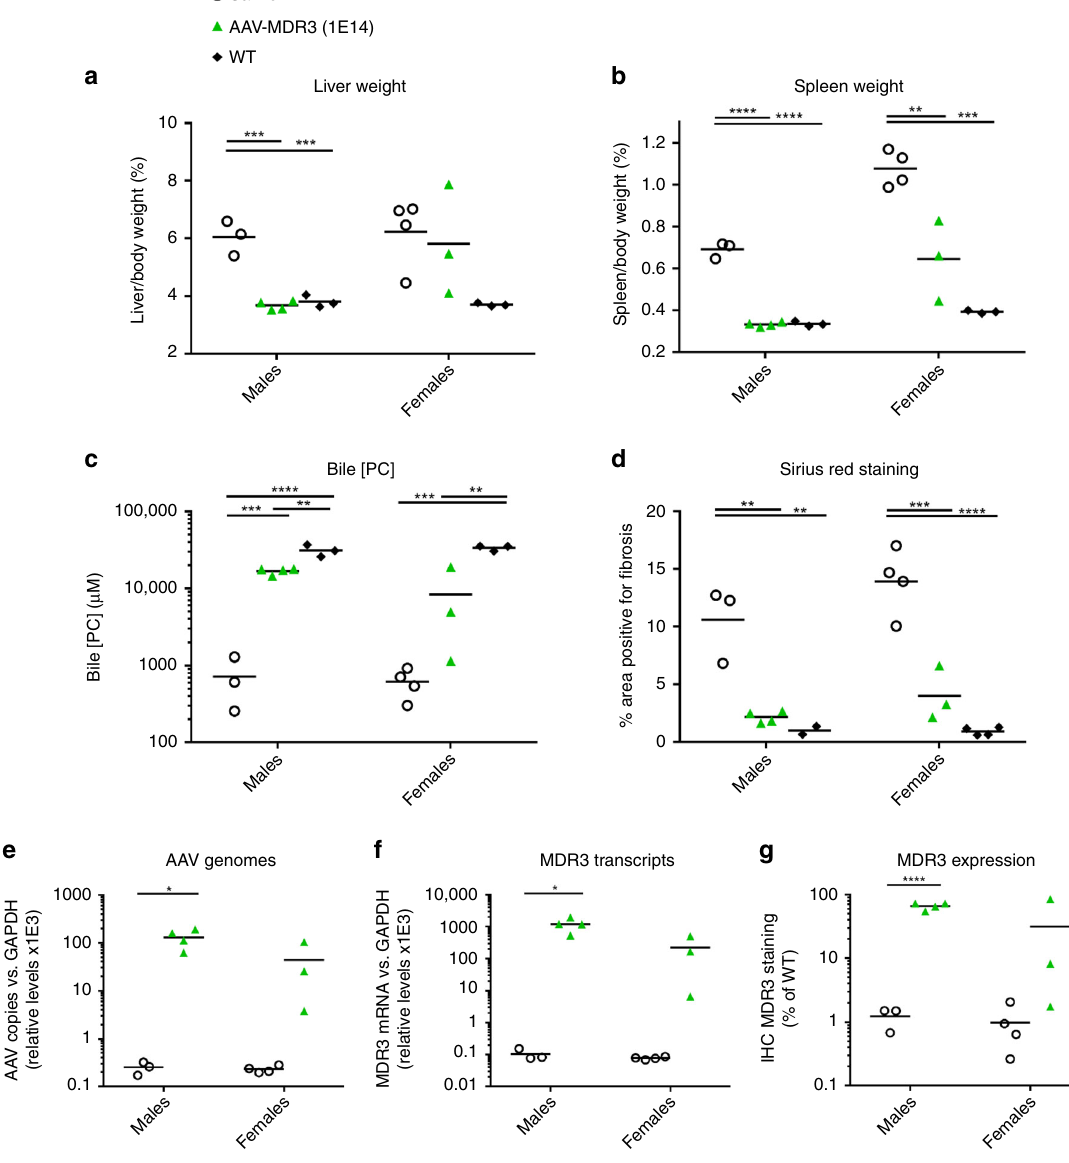
Fig. 7 PFIC3 disease parameters in Abcb4 − / − mice treated at 5 weeks of age with AAV-MDR3-Aco. At the time of sacri fi ce, liver ( a ) and spleen ( b ) weight as a percent of body weight, PC concentration in bile ( c ), liver fi brosis ( d ), AAV genomes ( e ), MDR3 transcripts ( f ), and MDR3 protein expression ( g ) were measured for Abcb4 − / − mice treated with AAV-MDR3-Aco at 1 × 10 14 VG/kg 1× (green triangles; n = 4 M/3 F), and saline-treated controls (open circles; n = 3 M/4 F) and untreated WT mice (black diamonds; n = 3 M/3 F). Animals were sacri fi ced 12 weeks after treatment. Statistics (one-way ANOVA/Tukey ’ s multiple comparisons test): *, p < 0.05; **, p < 0.01; ***, p < 0.001, ****, p < 0.0001. a – d F values and degrees of freedom (numerator, denominator): a males: F (2,7) = 44.52, females: F (2,7) = 3.558; b males: F (2,7) = 265.5, females: F (2,7) = 30.81; c males: F (2,7) = 69.93, females: F (2,7) = 35.8; d males: F (2,6) = 21.02, females: F (2,8) = 39.88. e – g Unpaired t test ( t -value and degree of freedom): e males: ( t = 3.938, df = 5), females: ( t = 1.737 df = 5); f males: ( t = 3.557, df = 5), females: ( t = 1.836, df = 5); g males: ( t = 12.61, df = 5), females: ( t = 1.37, df = 5). Source data are provided as a Source Data fi